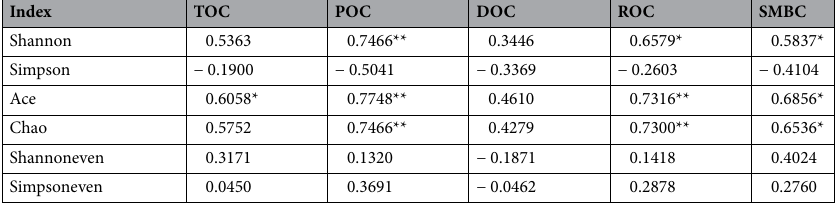
Table 4. Correlation coefficient test after multiple regression analysis of organic carbon components and bacterial diversity parameters. TOC soil total organic carbon, POC particulate organic carbon, DOC dissolved organic carbon, ROC oxidized organic carbon, SMBC soil microbial biomass carbon. * and ** indicate significant correlations of 5% and 1%,